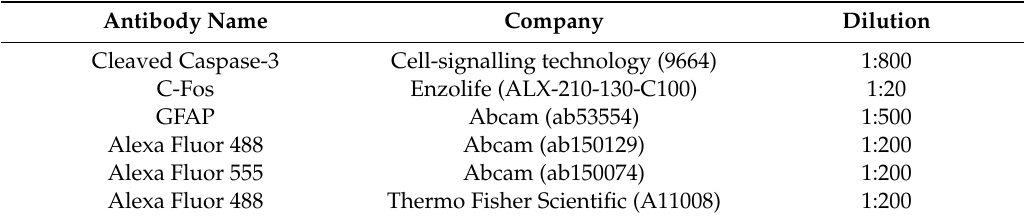
Table 3. List of antibodies used in